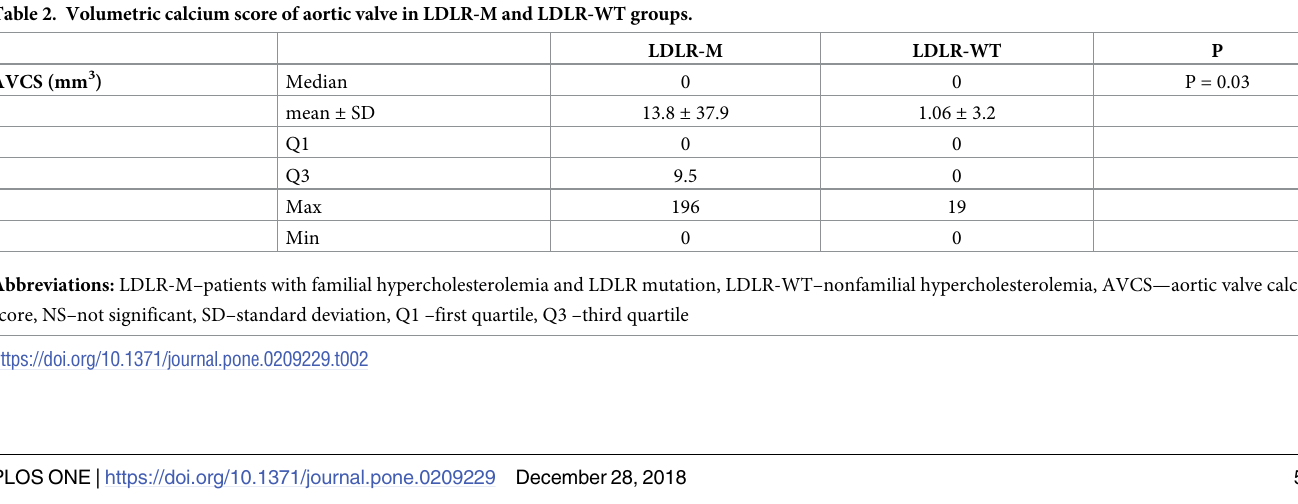
Abbreviations: LDLR-M–patients with hypercholesterolemia and confirmed LDLR mutation, LDLR-WT (LDLR-wild type)–patients with hypercholesterolemia and